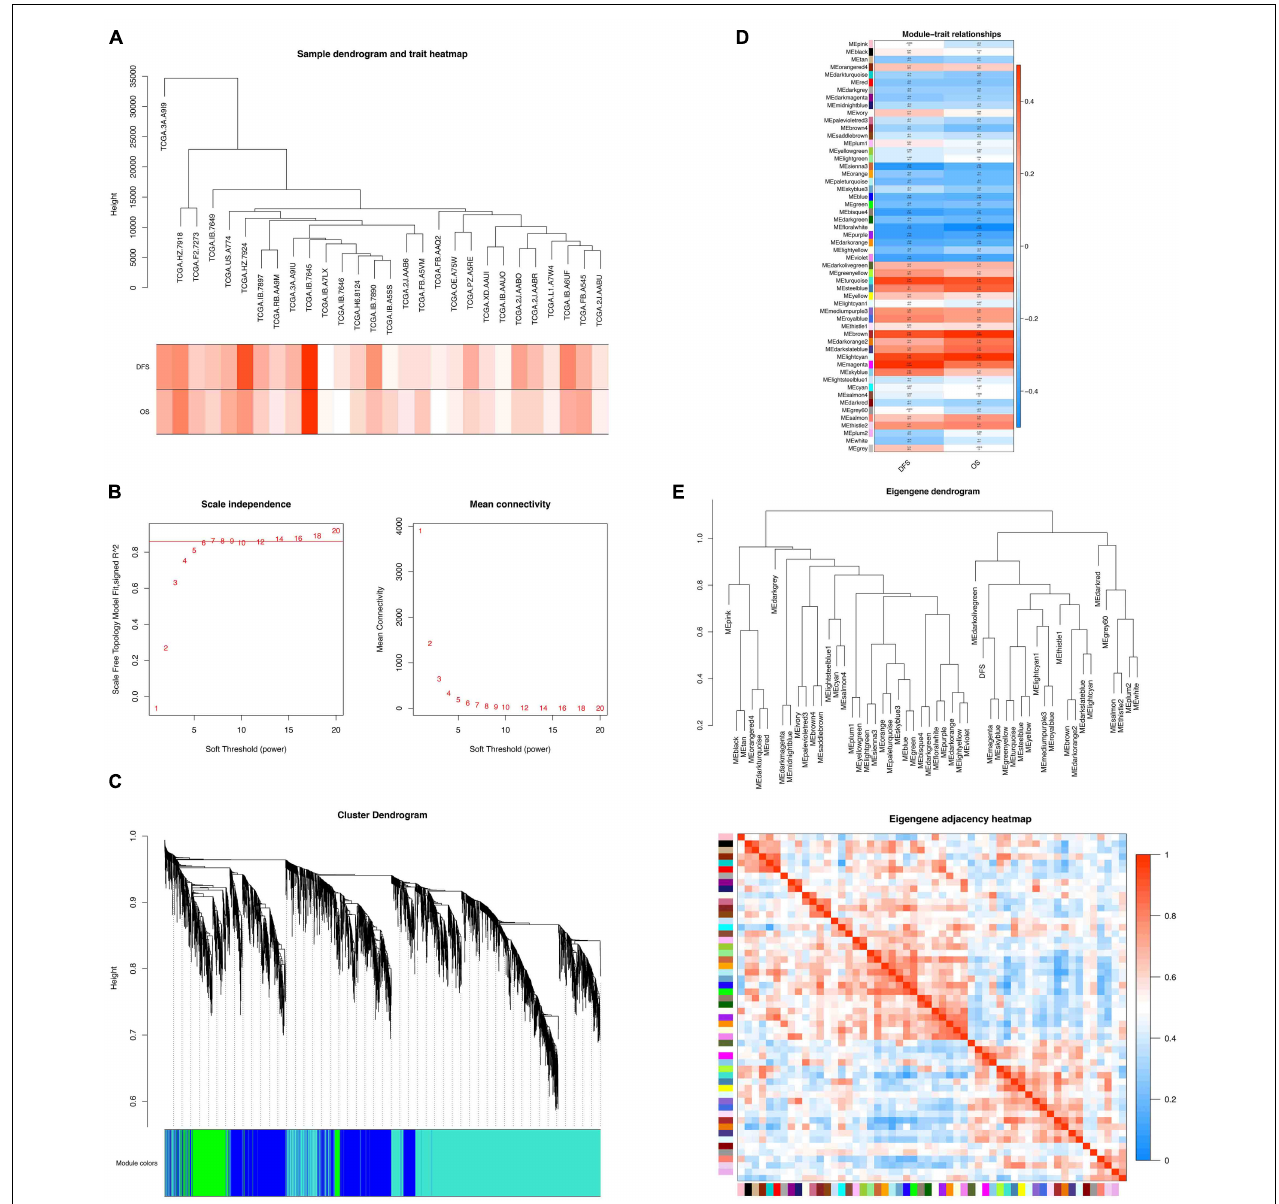
FIGURE 5 | WGCNA network of the liver metastasis group. (A) Clustering dendrogram of 28 samples. (B) Determination of soft-threshold power in the WGCNA. (C) Clustering dendrograms of identified co-expressed genes in modules in the liver metastasis group. Each colored row represents a color-coded module that contains a group of highly connected genes. (D) Heatmaps of the correlation between eigengene and DFS and OS of the liver metastasis group. Each row corresponds to an ME, and each cell contains the corresponding correlation (red, positively correlated; blue, negatively correlated) and p -value. (E) Dendrogram of MEs obtained by WGCNA and heatmap plot of the adjacencies of modules. Red represents high adjacency (positive correlation), and blue represents low adjacency (negative